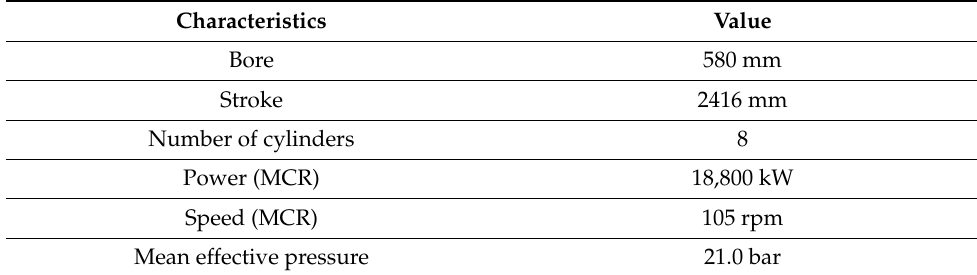
Table 5. Basic characteristics of a low-speed diesel engine WinGD RT- fl ex 58T-E (Data from: [36]). Characteristics